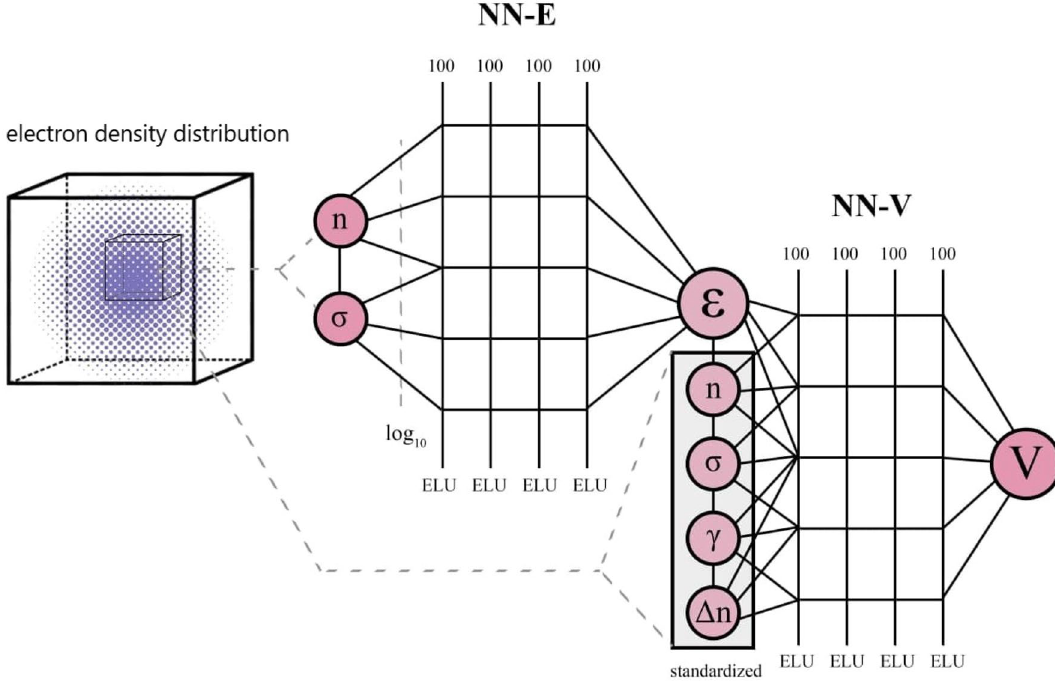
Figure 1. Topology of the XC neural network. It consists of two parts: NN-E predicts ε xc and NN-V predicts v xc . Each part of the neural network consists of 4 layers each of 100 neurons. For both parts information on local density and its derivatives is